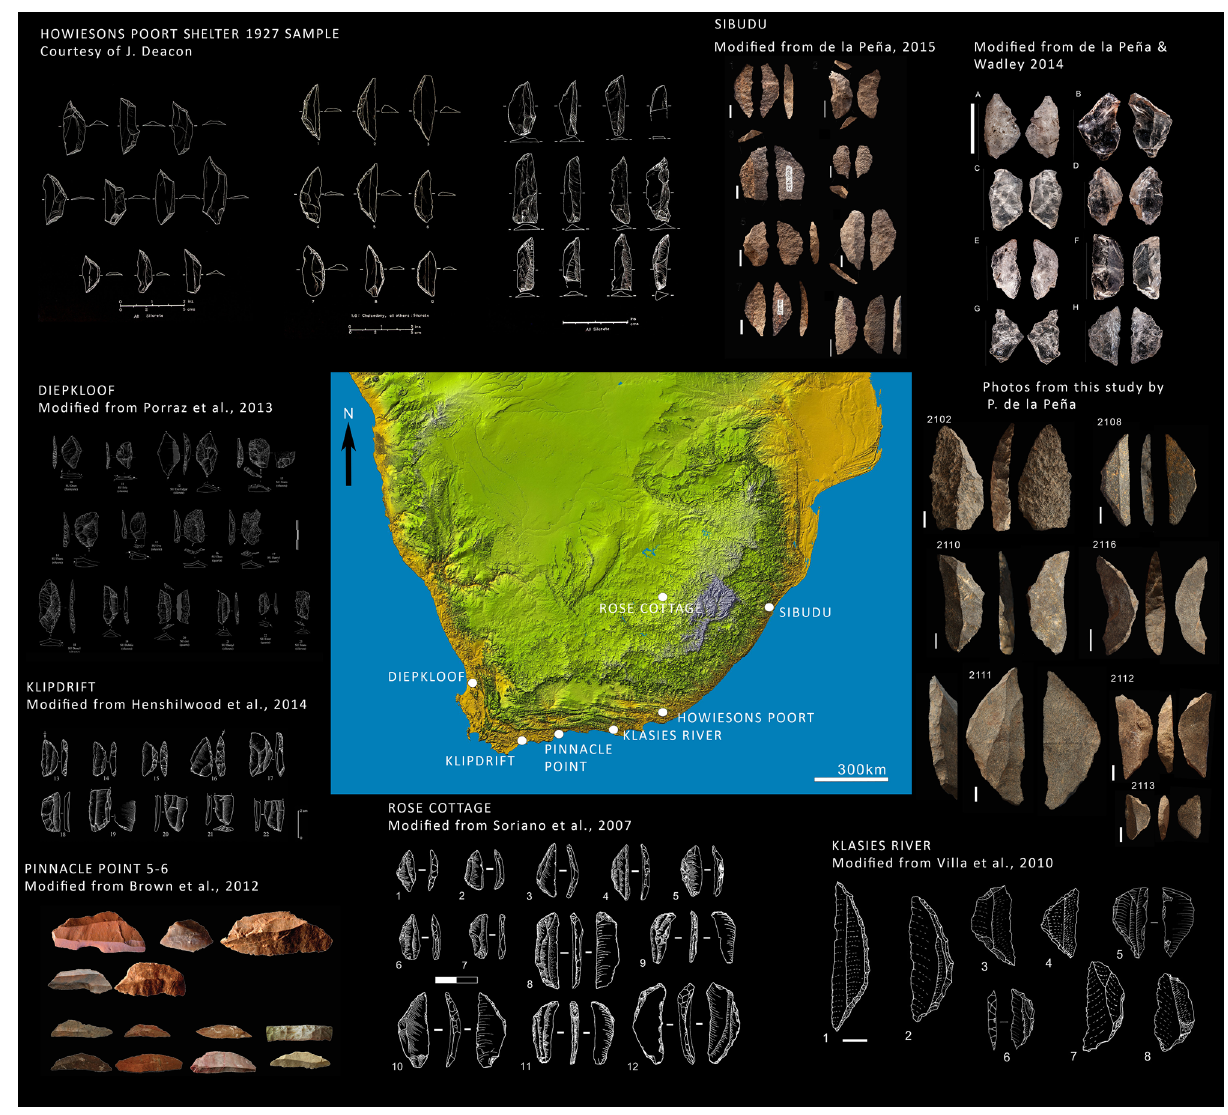
Figure 1. Map showing the location of the seven sites analyzed alongside a small selection of the backed pieces used for this analysis: Howiesons Poort Shelter eponymous site, Sibudu, Klasies River, Rose Cottage, Pinnacle Point 5–6, Klipdrift Shelter, and Diepkloof. The map is sourced from https:// www. jpl. nasa. gov/ images/ srtm- data- relea se- for- africa- color ed- height. The Howiesons Poort site artifacts are shown courtesy of J. Deacon 14 . The Sibudu crystal quartz (Grey Sand layer) are reproduced from 8 ; dolerite (Grey rocky layer), to the left of the quartz are reproduced from 18 and hornfels (Grey rocky layer), below the quartz, were photographed for this study. Klasies River backed pieces are from HP lower, middle and upper: (1,2,3,4,7 and 8) quartzite; (5,6,7) silcrete; modified from 64 . Rose Cottage opaline backed pieces; (1) Level EMD; (2) Level EMD; (3,5,6,7,8,12) Level MAS; (5,10) Level SUZ; modified from 38 . Pinnacle Point 5–6 backed pieces from the DBCS (HP) and SADBS layers, modified from 24 . Klipdrift Shelter’s backed pieces were modified from 65 and come from layer PCA, PBC, PBA/PBB, layer PBD (quartz and silcrete). Diepkloof’s backed pieces are from the late HP on silcrete and quartz, drawings by M. Grenet, modified from 20 . This figure provides a visible representation of the variability of backed pieces in southern Africa. This figure was created with Adobe Photoshop CS6 www. adobe. com by